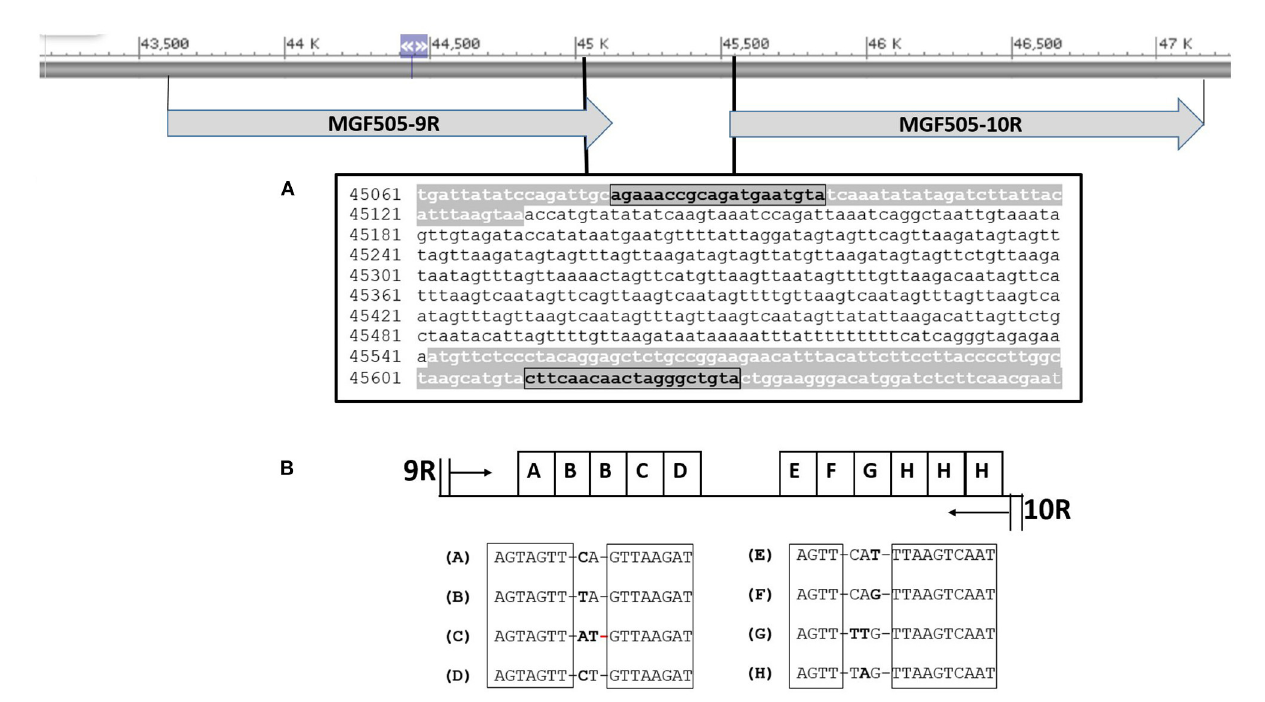
FIGURE3 Map showing the location of the IGR between the 9R - 10R genes of MGF505 in reference to Georgia ASFV 2007/1. (A) Nucleotide sequence of the product amplified with the 505U/505L primers marked in bold. In gray the sequence of the 9R and 10R genes is shown. (B) Arrangement and identification of intergenic tandem repeat sequences (TRS). The conserved nucleotides in all TRS are boxed.